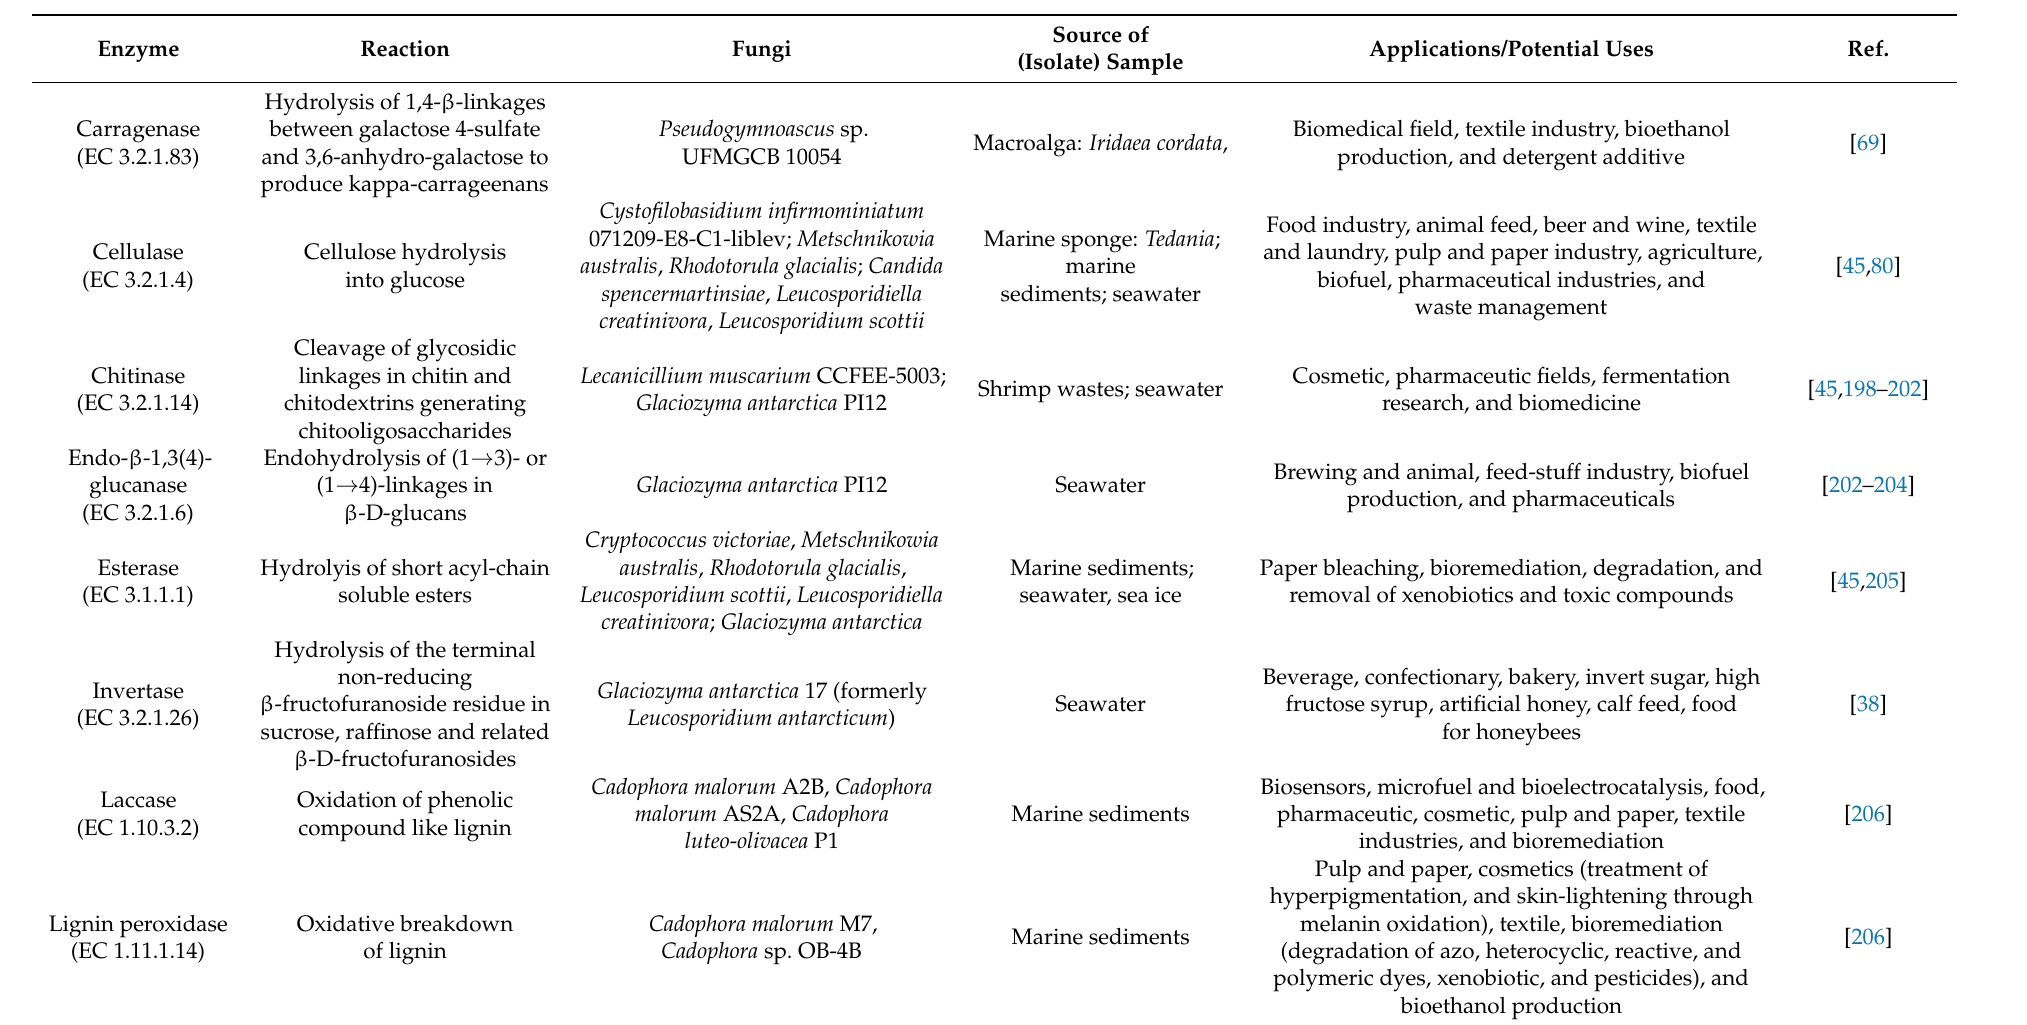
Table 2. Examples of extremophilic fungi as a source of cold-adapted enzymes utilized in industrial applications. The fungal taxa reported are isolated from Antarctic marine environments: seawater, marine sediments, and